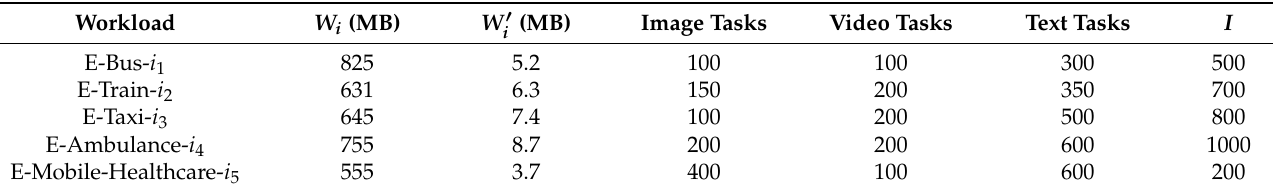
Table 3. E-Transport